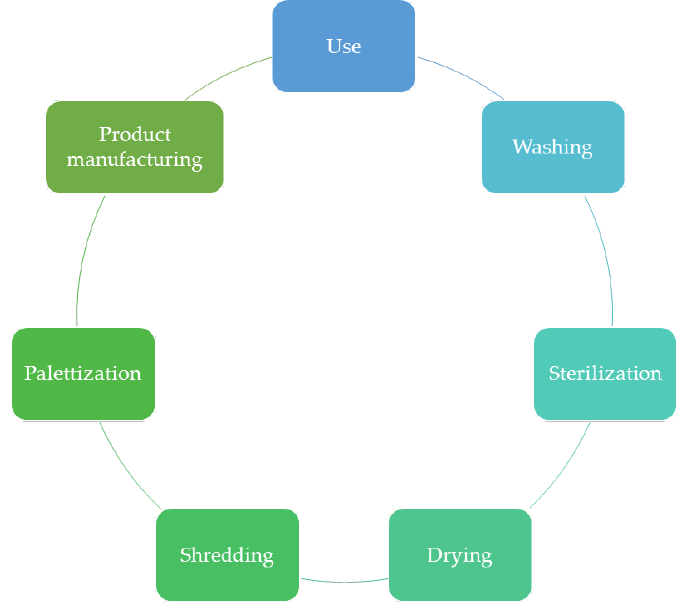
Figure 1. Circular clinical plastics economy configuration.